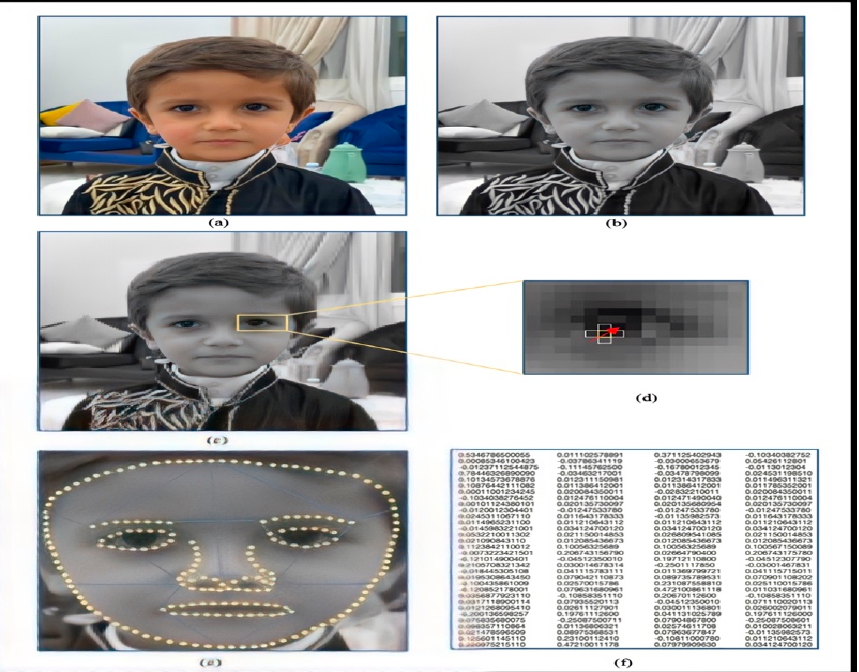
Figure 3. Face-recognition Library procedures ( a ) represents The library received image, ( b ) rep- resents converting the image to a black and white, ( c , d ) represent that each pixel of the image is watched and gradations of brightness, ( e ) represents the basic structure of the face, and ( f ) represents 128 facial